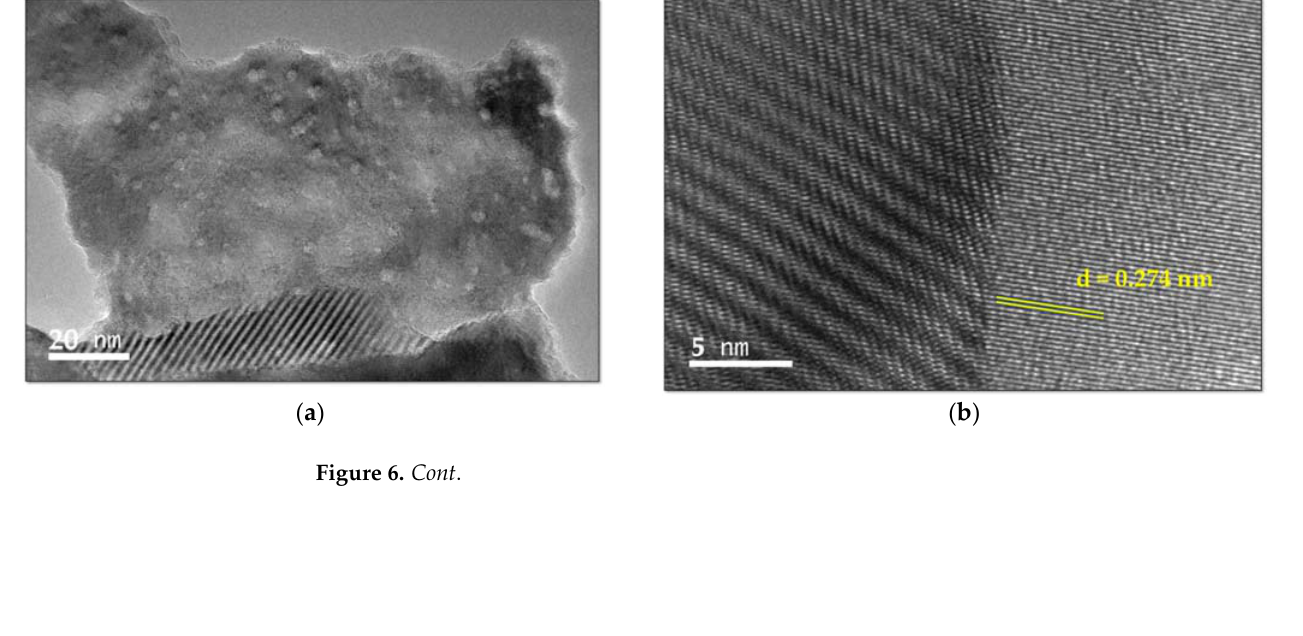
Figure 5. The scanning electron microscopy (SEM) of [Cu(12 ‐ crown ‐ 4) 2 ]I 5 ( a ) 1 μ m; ( b ) 500 nm.